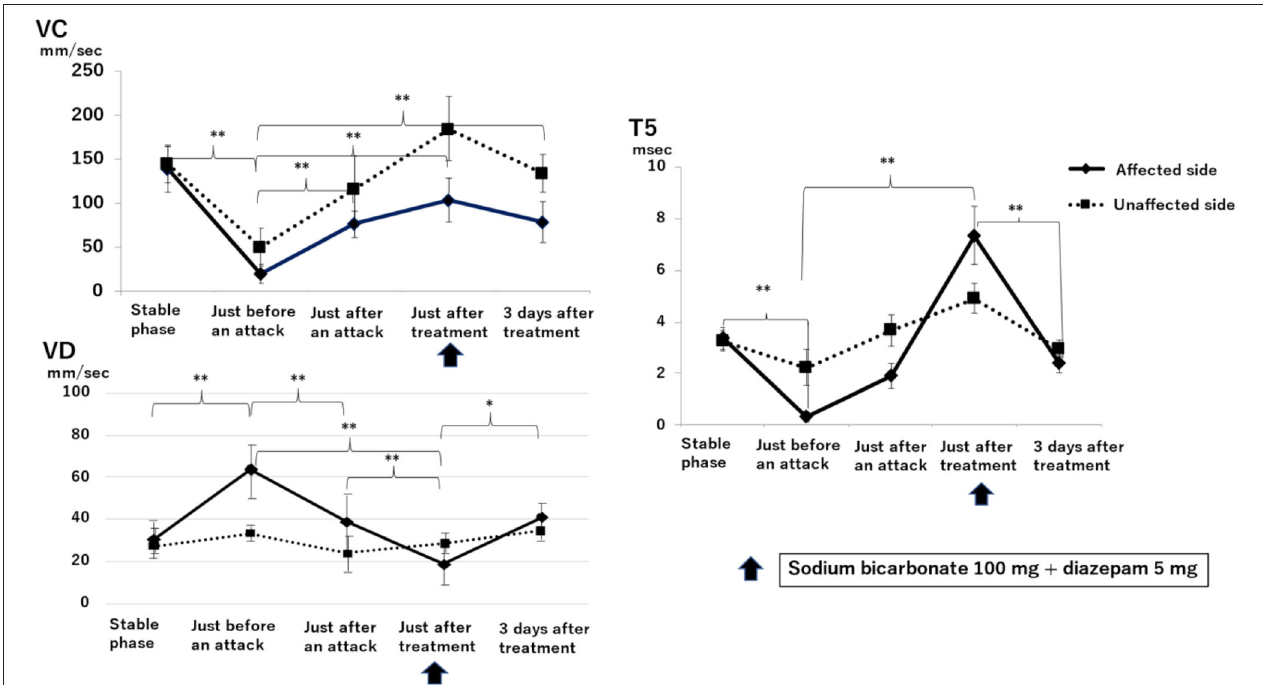
FIGURE 3 | Sequential changes in the autonomic nervous system as measured by electronic pupillometry just before, just after, and 3 days after a Ménière’s disease attack. Maximum constriction velocity, VC (mm/sec): larger values indicate a more activated parasympathetic nervous system. Maximum dilation velocity, VD (mm/sec): larger values indicate a more activated the sympathetic nervous system. T5 (msec): smaller values indicate a more activated sympathetic nervous system. An infusion of 100mg sodium bicarbonate plus 5mg diazepam was administered for its antiemetic effect once just after an attack. A significant reduction in parasympathetic activity and excitation of sympathetic activity was found on the affected side just before an attack. Just after an attack, parasympathetic activity on the affected side was activated, followed by the recovery of parasympathetic activity and suppression of sympathetic activity after treatment. Results with statistically significant differences by two-factor ANOVA and then Scheffe’s F-test (multiple comparison test) are shown between curly brackets. ** P < 0.01, * P < 0.05. Data are presented as mean ± standard deviation ( n =